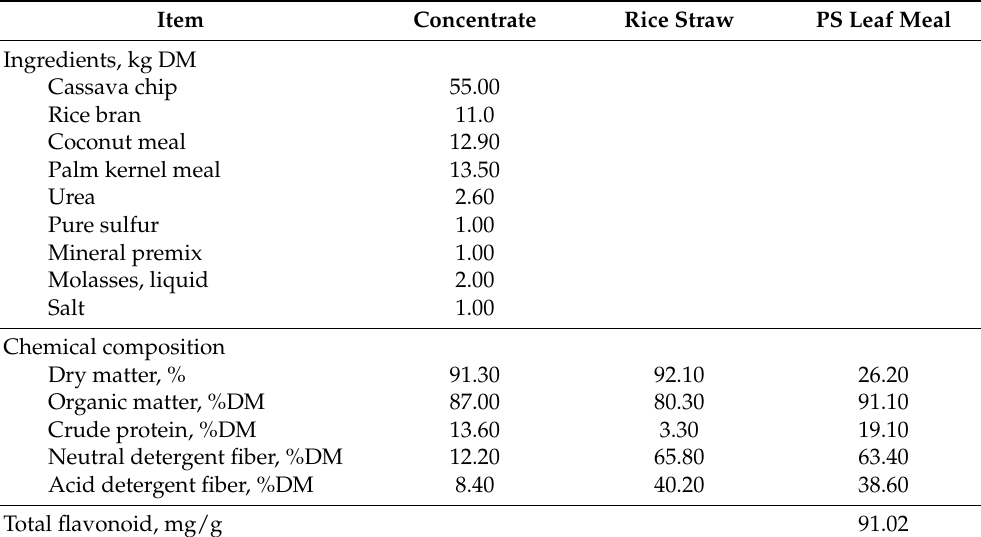
Table 1. The proportion of ingredients in concentrate and nutrient contents of concentrate, rice straw and Piper sarmentosum (PS) leaf meal used in